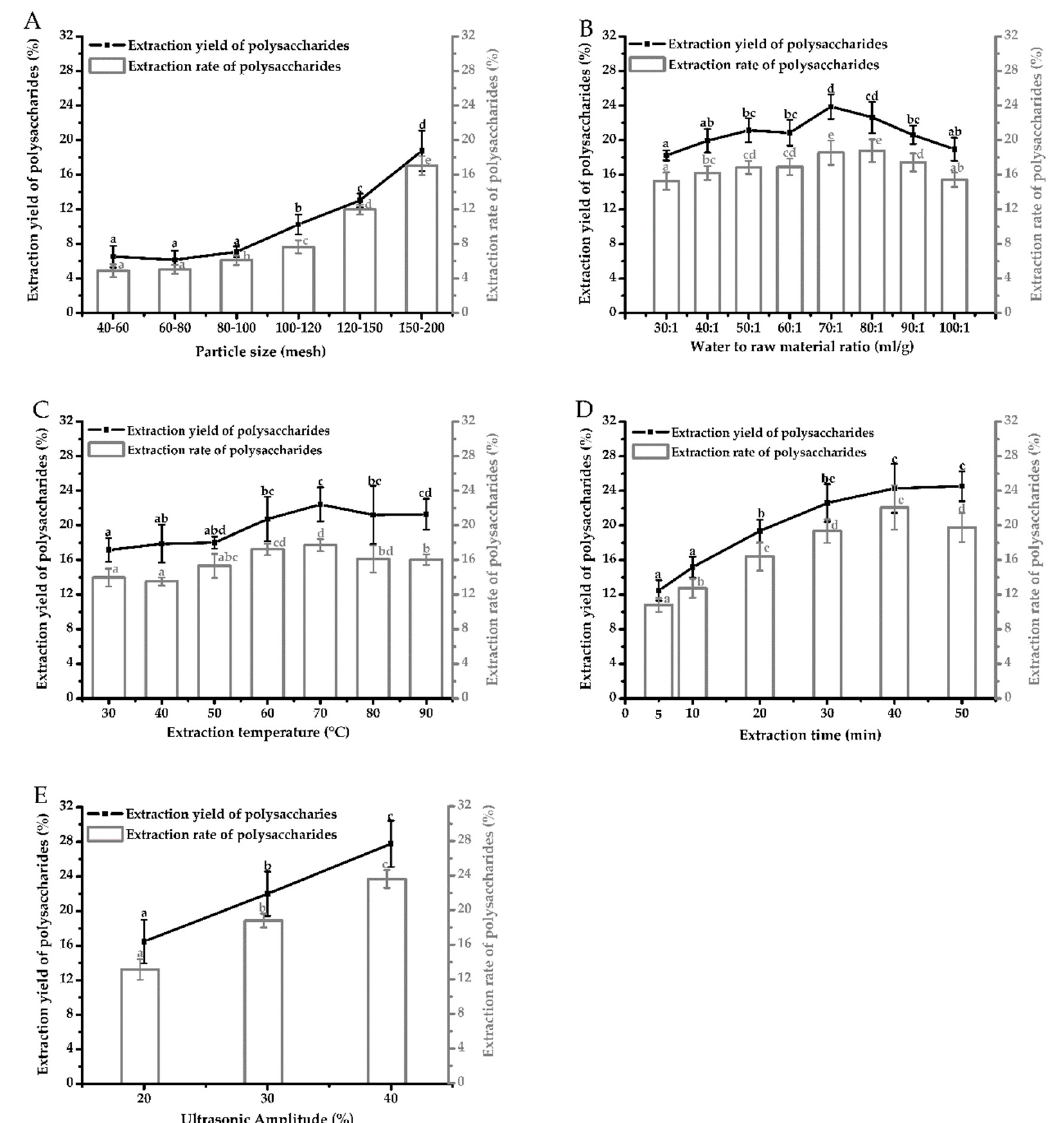
Figure 1. Effects of single-factor ( A ) particle size ( B ) water to raw material ratio ( C ) extraction temperature ( D ) extraction time ( E ) ultrasonic amplitude by ultrasound-assisted extraction (UAE) on extraction yield and extraction rate of polysaccharides from Auricularia cornea var. Li. Values with different letters are significantly different ( P < 0.05) for extraction yield and extraction rate of polysaccharides.